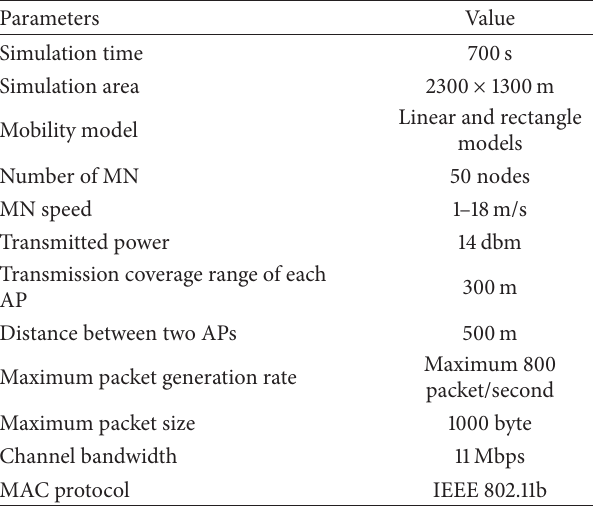
Table 9: Simulation